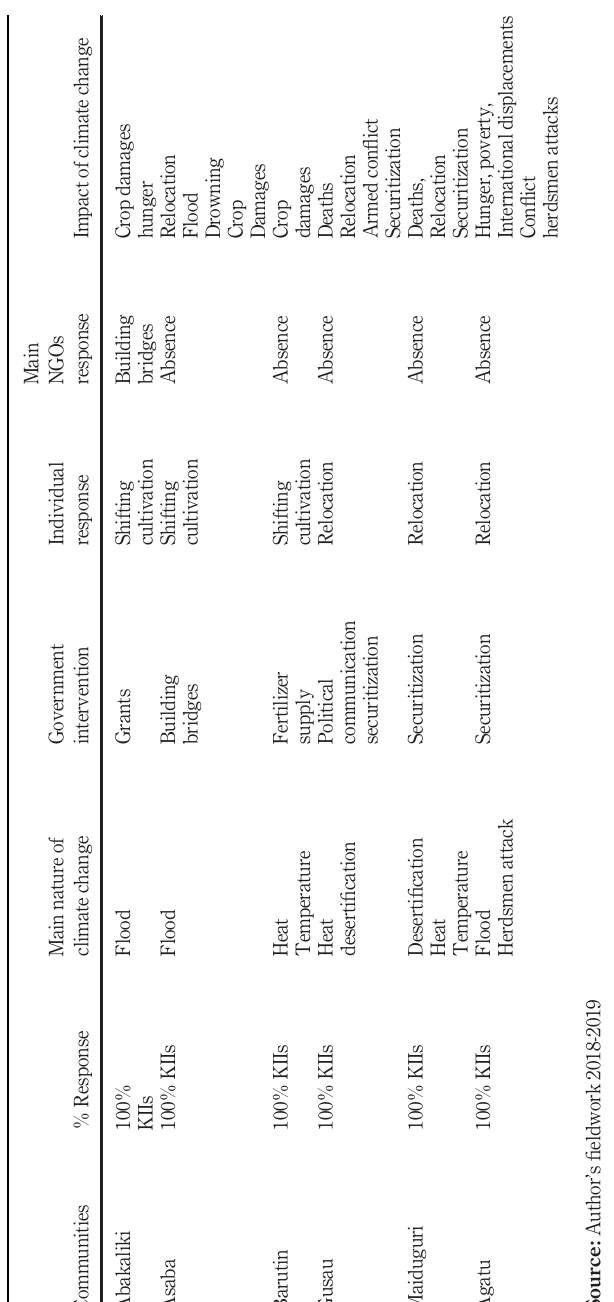
Table 1. Stakeholders ’ perceptions/reactions to climate change and food/human